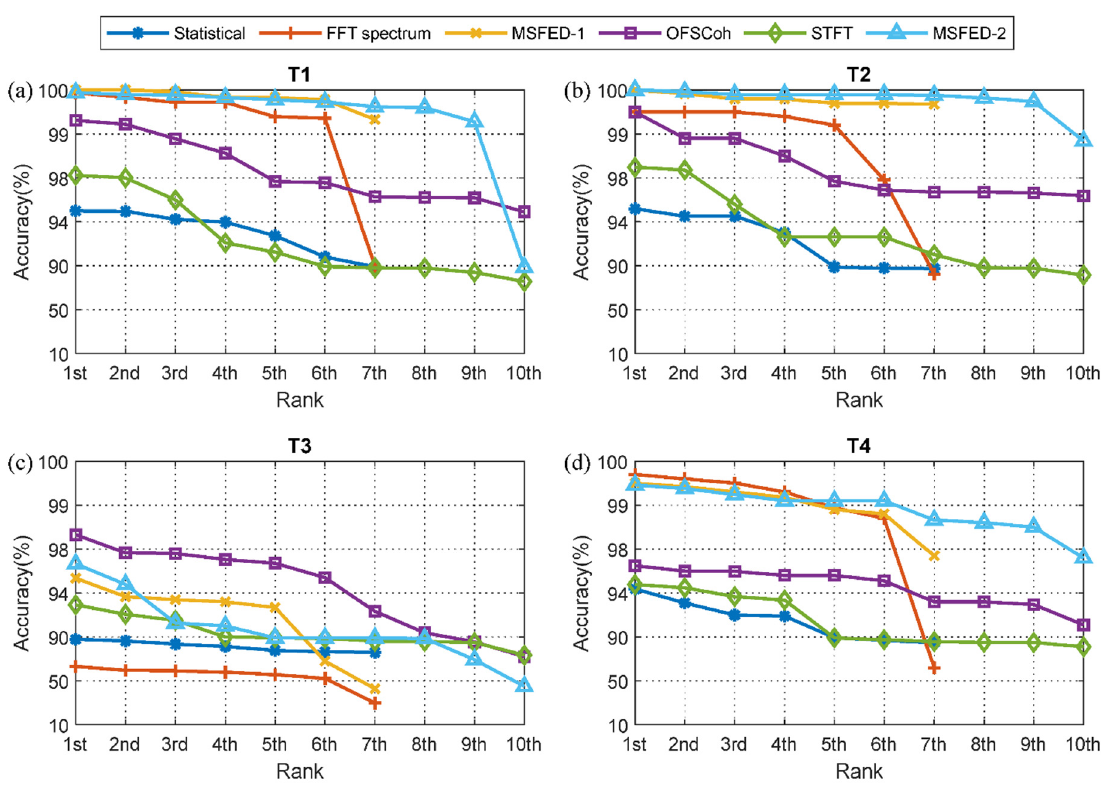
Figure 8. Diagnostic accuracy of different features and models on four tasks: ( a ) T1, ( b ) T2, ( c ) T3, and ( d ) T4.